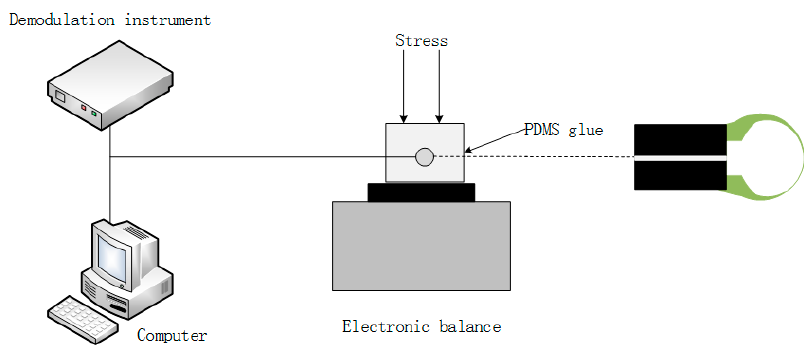
Figure 4. Setup for measuring the reflection spectrum of the micro bubble strain sensor.